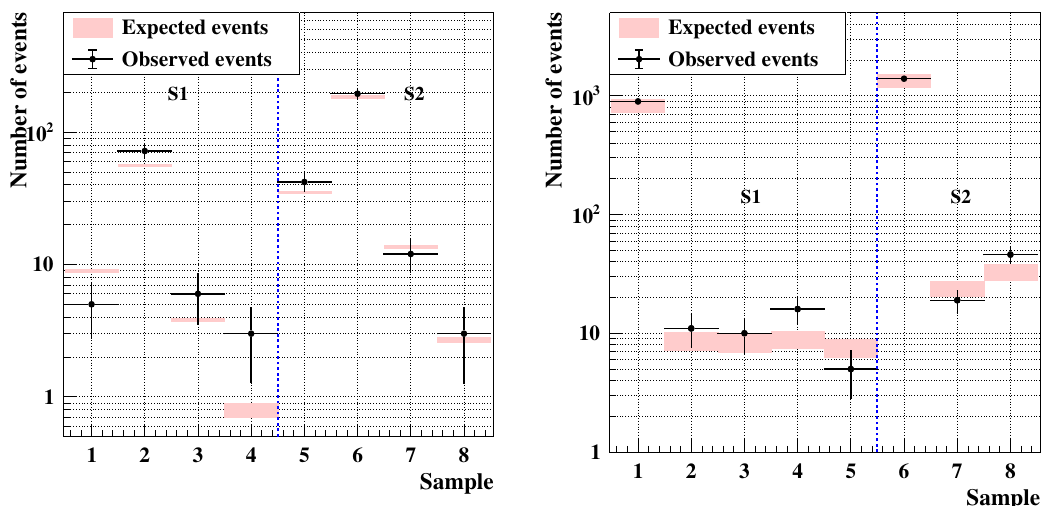
Figure 4 . Validation of the K + → π + π − e + ν and upstream backgrounds. Left: comparison between expected and observed number of events for the K + → π + π − e + ν validation samples in the S1 (1–4) and S2 (5–8) subsets. Right: comparison between expected and observed number of events for the upstream background validation samples in the S1 (1–5) and S2 (6–8) subsets.